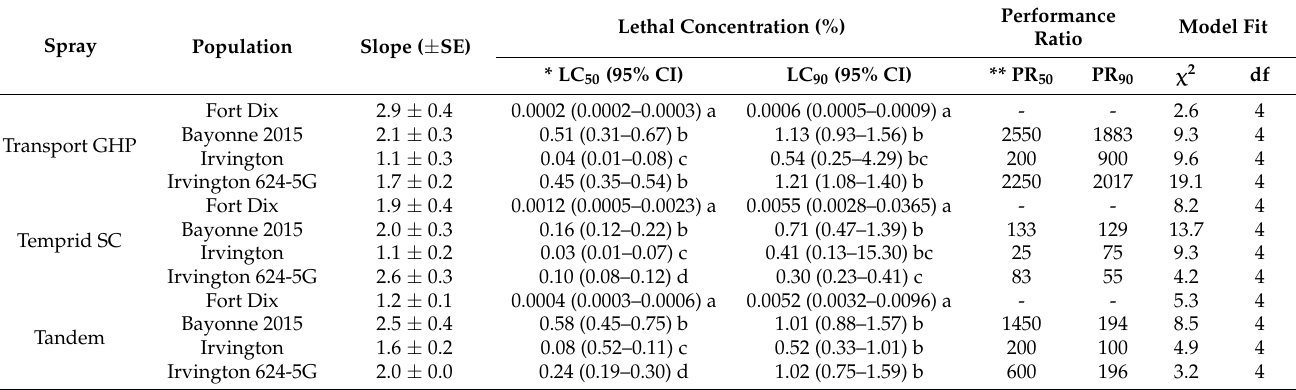
Table 5. Performance of three formulated insecticide mixture products against one laboratory strain (Fort Dix) and three field-collected C. lectularius populations. Bed bug morality was recorded at 72